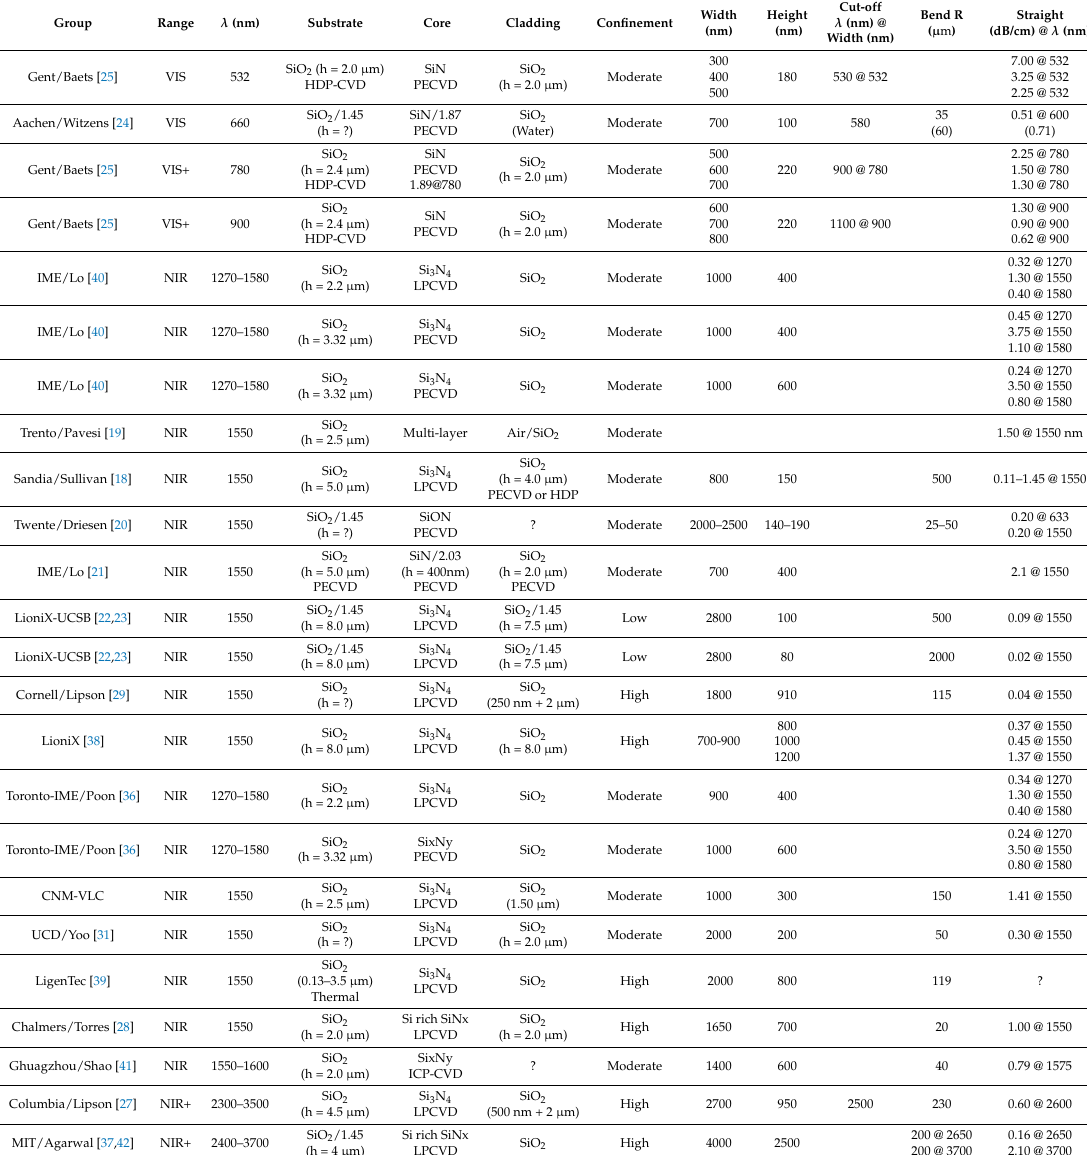
Table 1. State of the art of silicon nitride strip waveguide